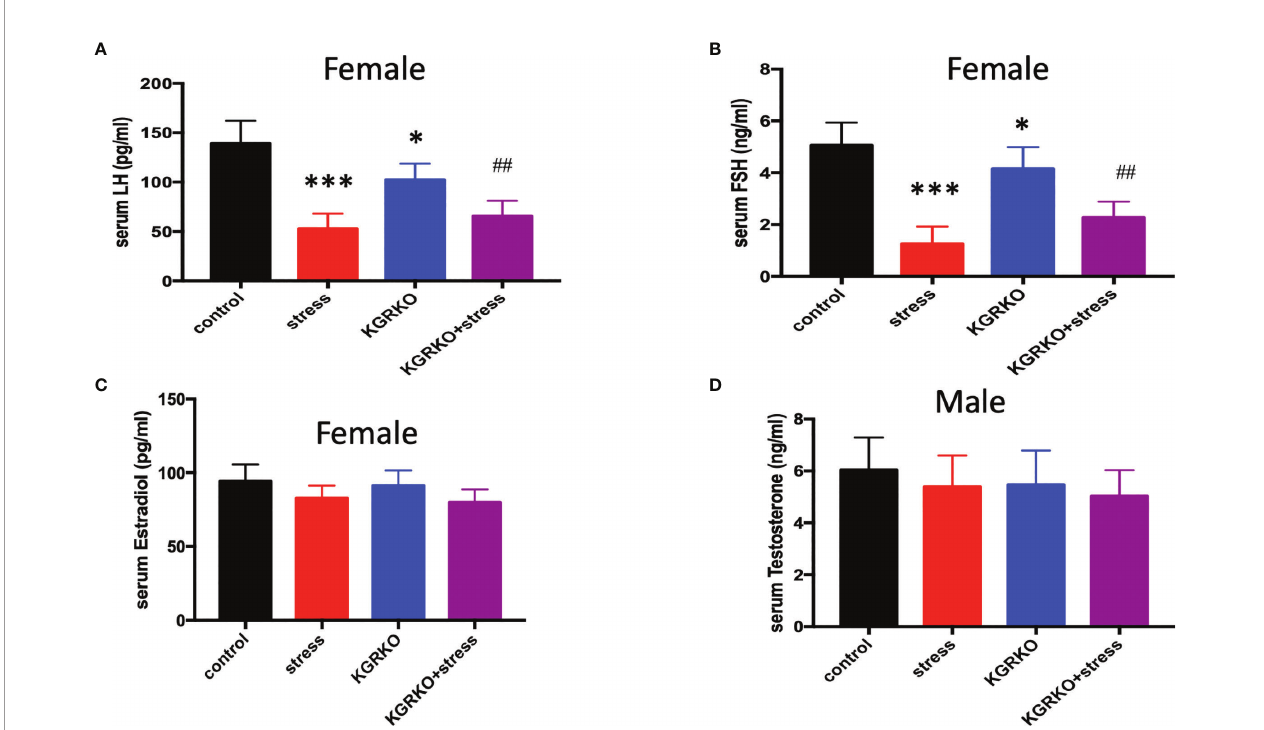
FIGURE 3 | The effect of chronic restraint stress on sex hormones in KGRKO mice. (A) LH level in female mice; (B) FSH level in female mice; (C) Estrodiol level in female mice; (D) Testosterone level in male mice; control: control group, stress: restraint stress group. KGRKO group: Kisspeptin neuron-speci fi c GR knockout mice. KGRKO+stress group: Kisspeptin neuron-speci fi c GR knockout mice restraint stress group. *Represents the comparison with the control group, P<0.05. ## Represents the comparison with the KGRKO group, P < 0.01. ***Represents the comparison with the control group, P <